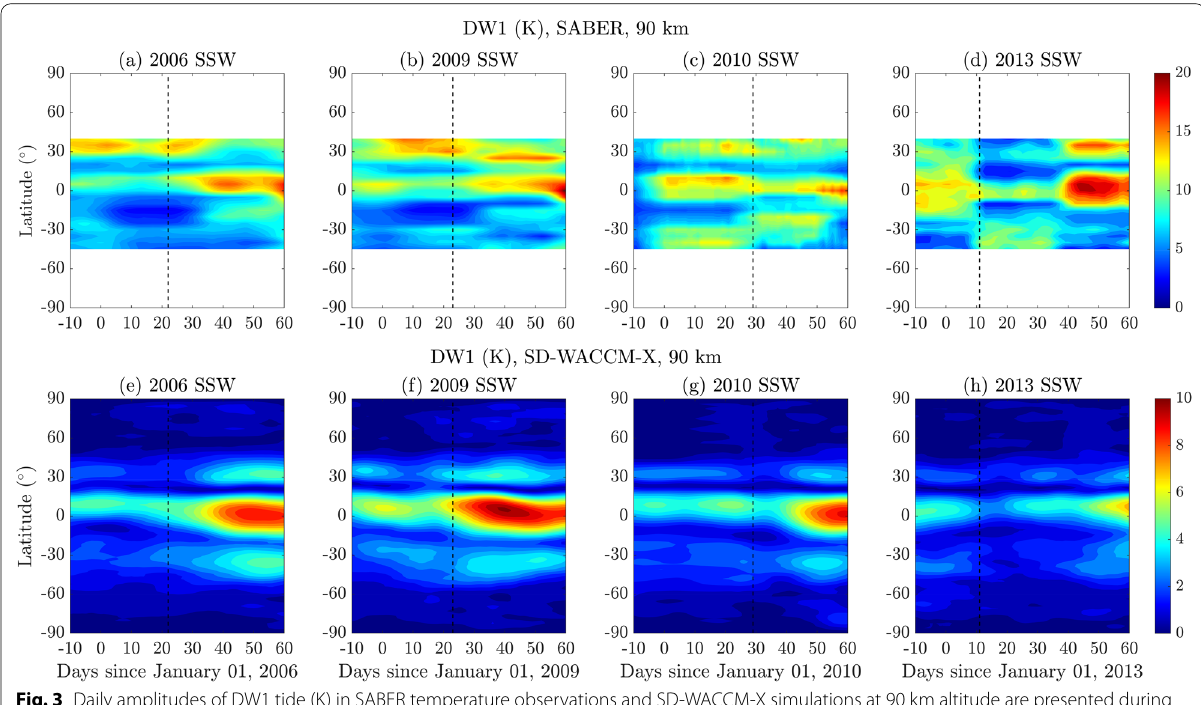
Fig. 3 Daily amplitudes of DW1 tide (K) in SABER temperature observations and SD-WACCM-X simulations at 90 km altitude are presented during ( a , e ) 2006, ( b , f ) 2009, ( c , g ) 2010, ( d , h ) 2013 NH SSWs in the top and bottom panels, respectively. Note the difference in scale of the colorbars in the upper and lower